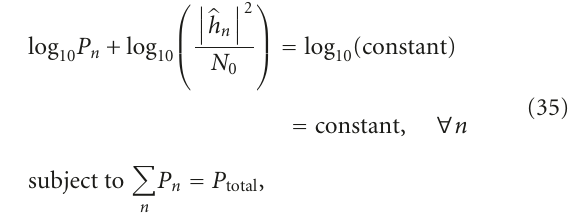
which is equal to C EP,Independent